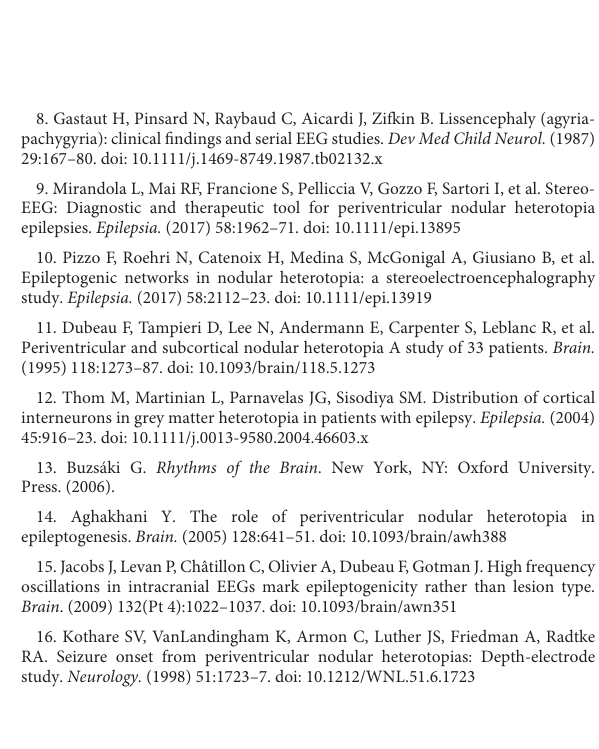
SUPPLEMENTARYFIGURE1 Example of multichannel data showing three patterns within a single time period . SUPPLEMENTARYFIGURE2 Correlation LFP between micro- and macro-contacts. For each Nodule and each pattern, the microelectrode LFP is correlated with each macro-contact of the same shaft (1 = closest to microelectrode, 8 = farthest from microelectrode). Macro-contacts were bipolar referenced. The numbers and size of markers denote positive (yellow) and negative (blue) correlation values. Note the largest correlation with the closest macro-contact, as well as the flip of correlation values in the next contact, showing that the patterns were highly localized to the tip of the shaft. SUPPLEMENTARYFIGURE3 Representative SEEG recordings obtained from the three patients during the clinical